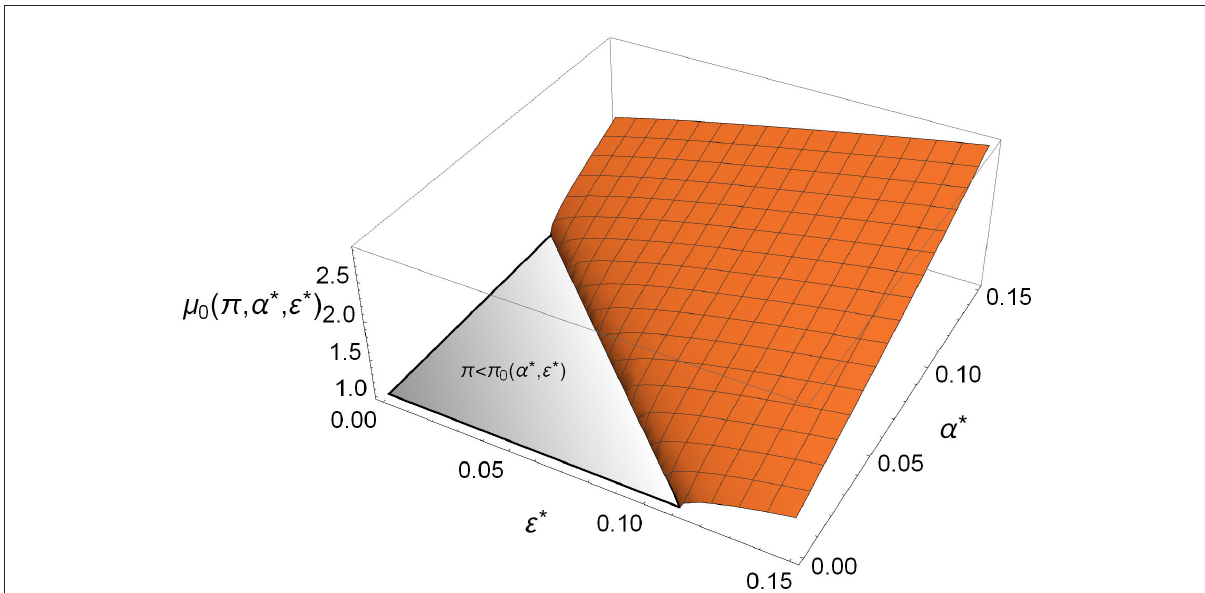
FIGURE3 The critical toxin efficiency ( µ 0 ) in the function of direct competition ( α * ) and immune system facilitation ( ε * ) . The gray triangle denotes the region where rare Aliivibrio always/spreads in the Mycoplasma -dominated microbiome [ π < π 0 ( α * , ε * ) ]. The orange region covers the α * , ε * values where rare Aliivibrio cannot invade. If the actual µ < µ 0 ( π , α * , ε * ) which can be satisfied more easily when α * , ε * are bigger, then the host is defended from the invasion of even a high dose of Aliivibrio , ( π = 0.9).